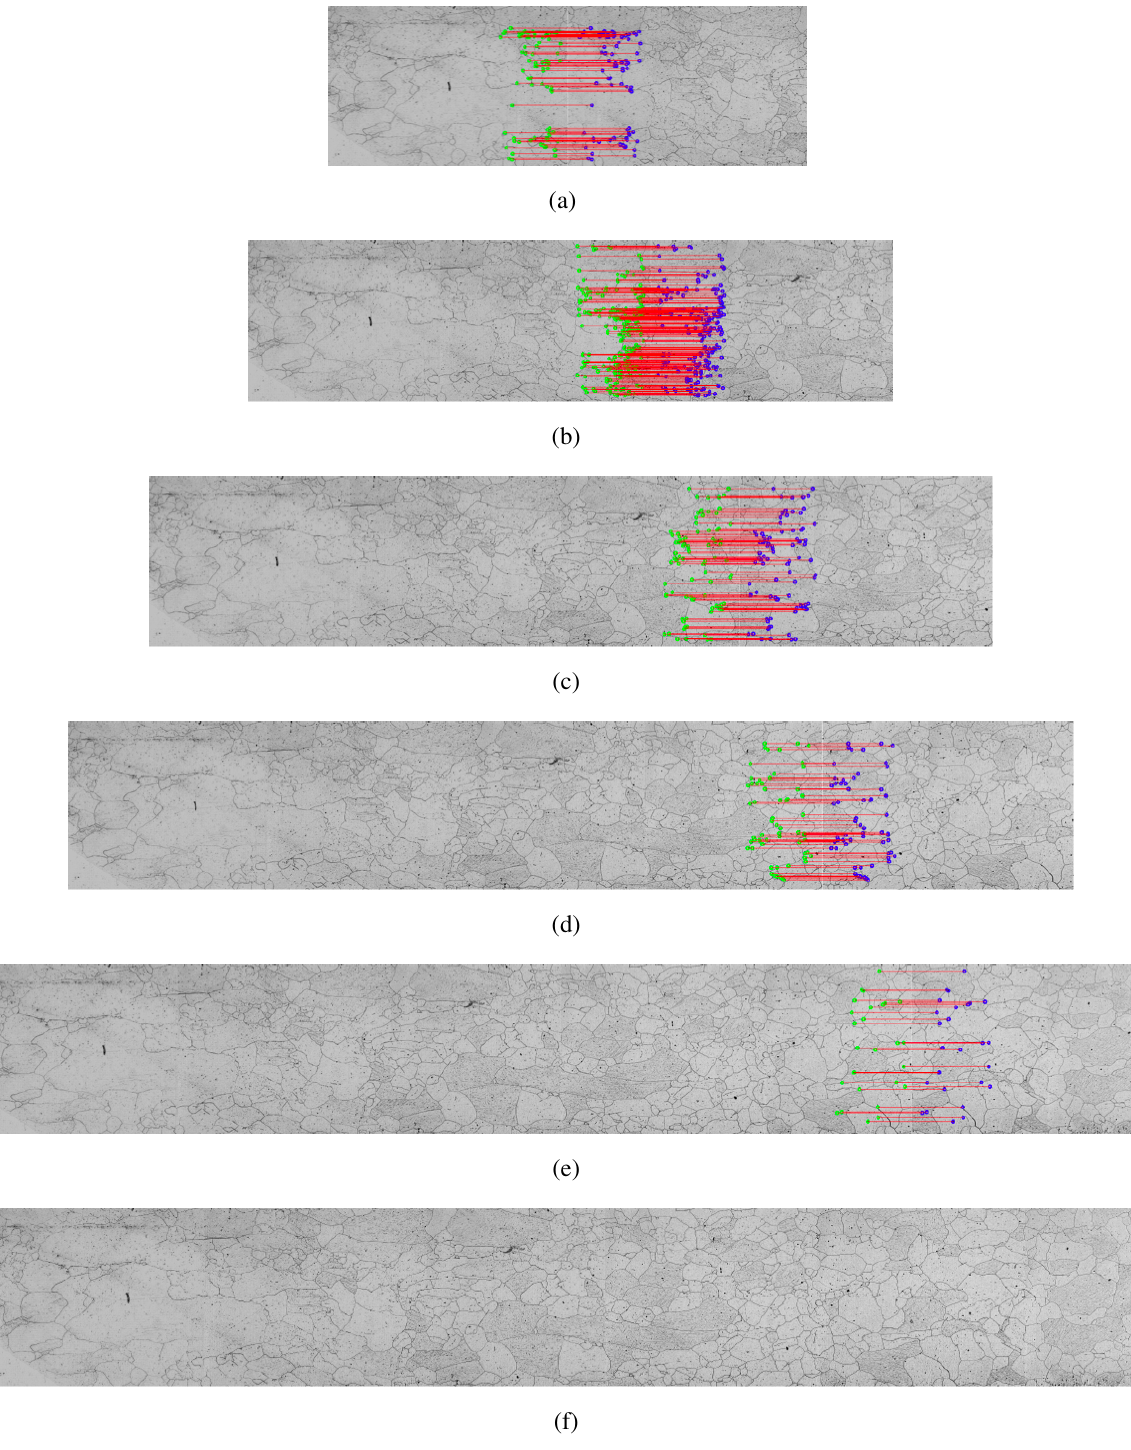
Figure 6. Mosaic construction example from the SIFT method using RANSAC Homography method to find the matrix and the Linear Interpolation method for constructing mosaic images using the five images collected by the microscope—sample 12, ( a ) first step, mosaic of the two initial images; ( b )–( e ) mosaic previous result with an adjacent image; ( f ) final